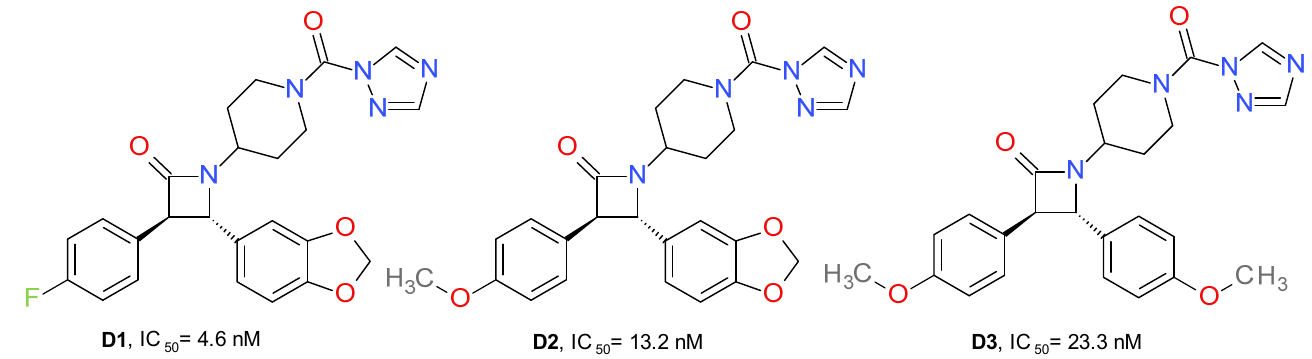
Figure 6. Irreversible MAGL inhibitors— trans -3,4-diarylsubstituted β -lactam derivatives.